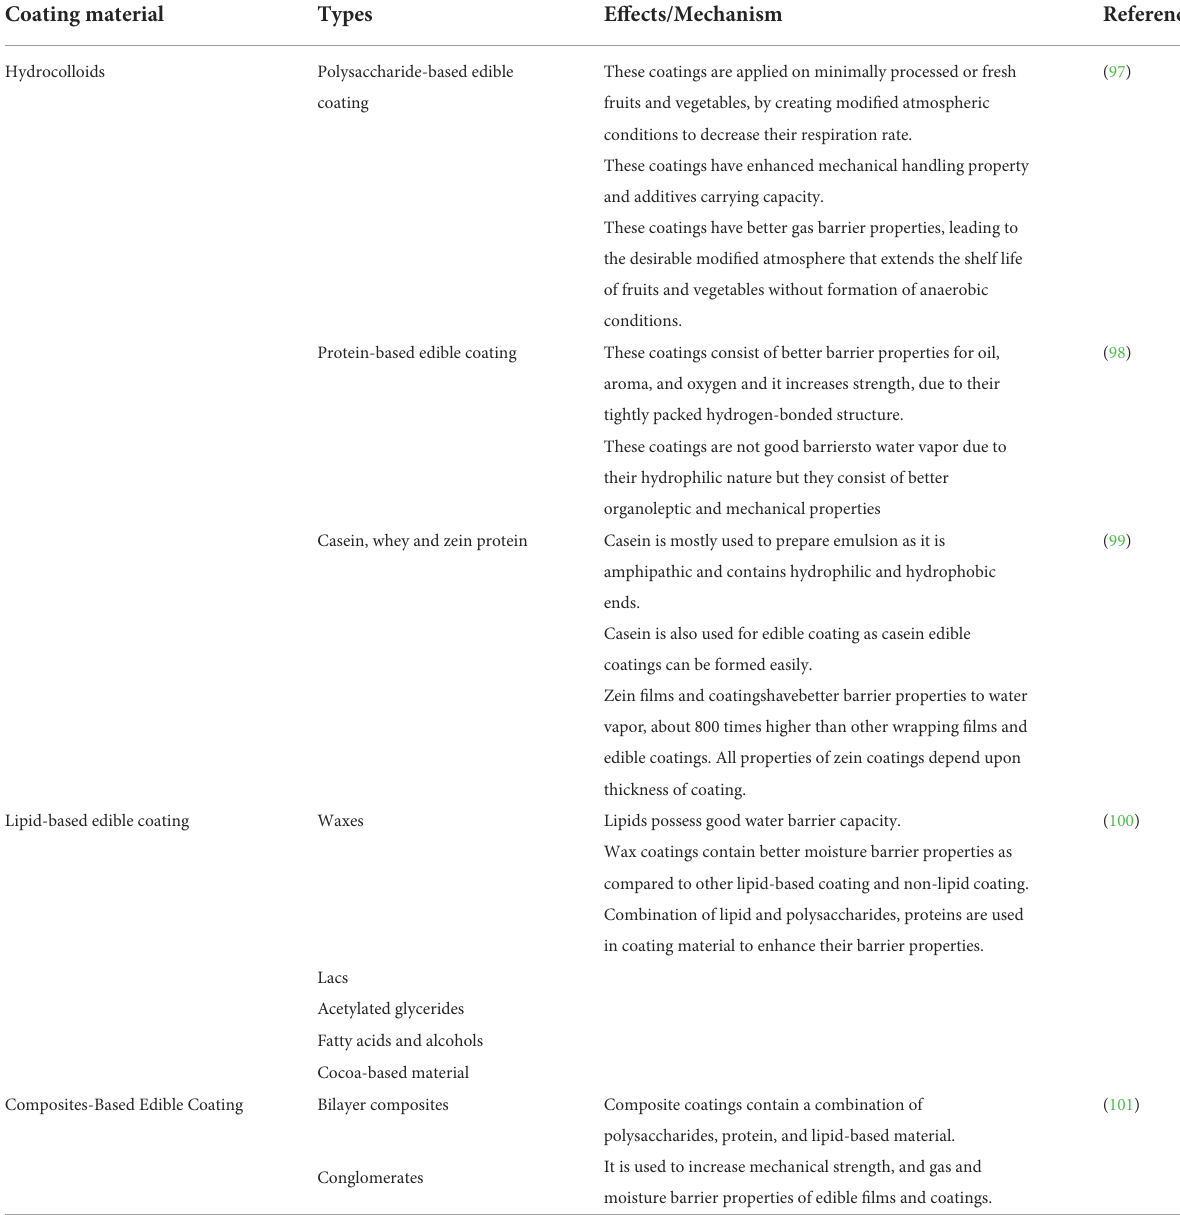
TABLE 4 Types of coating materials with mechanism and